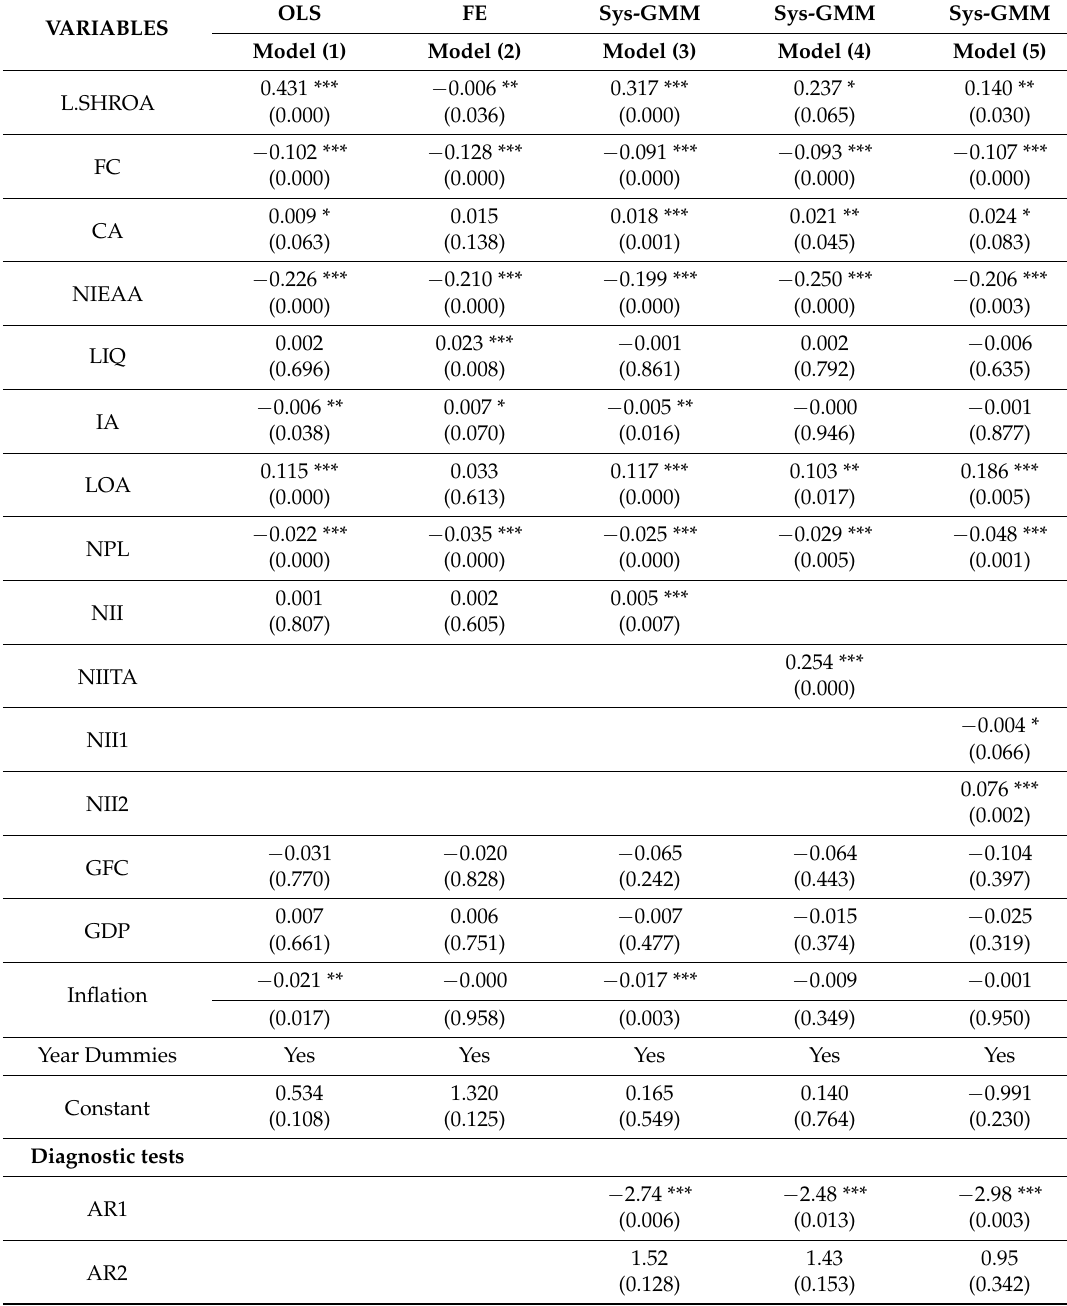
Table 10. SHROA (bank stability) as dependent variable for sample excluding Indian